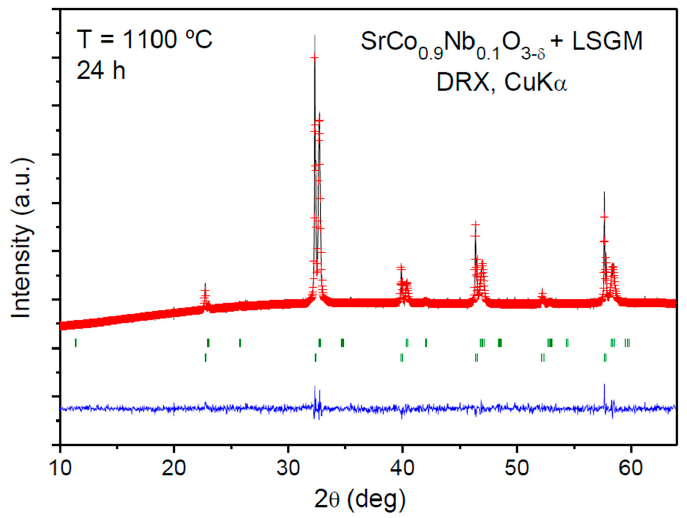
Figure 7. Rietveld-refined XRD profiles of a mixture of SrCo 0.9 Nb 0.1 O 3 − δ and La 0.8 Sr 0.2 Ga 0.83 Mg 0.17 O 3 − δ (LSGM) after thermal treatment at 1100 °C for 24 h in air.